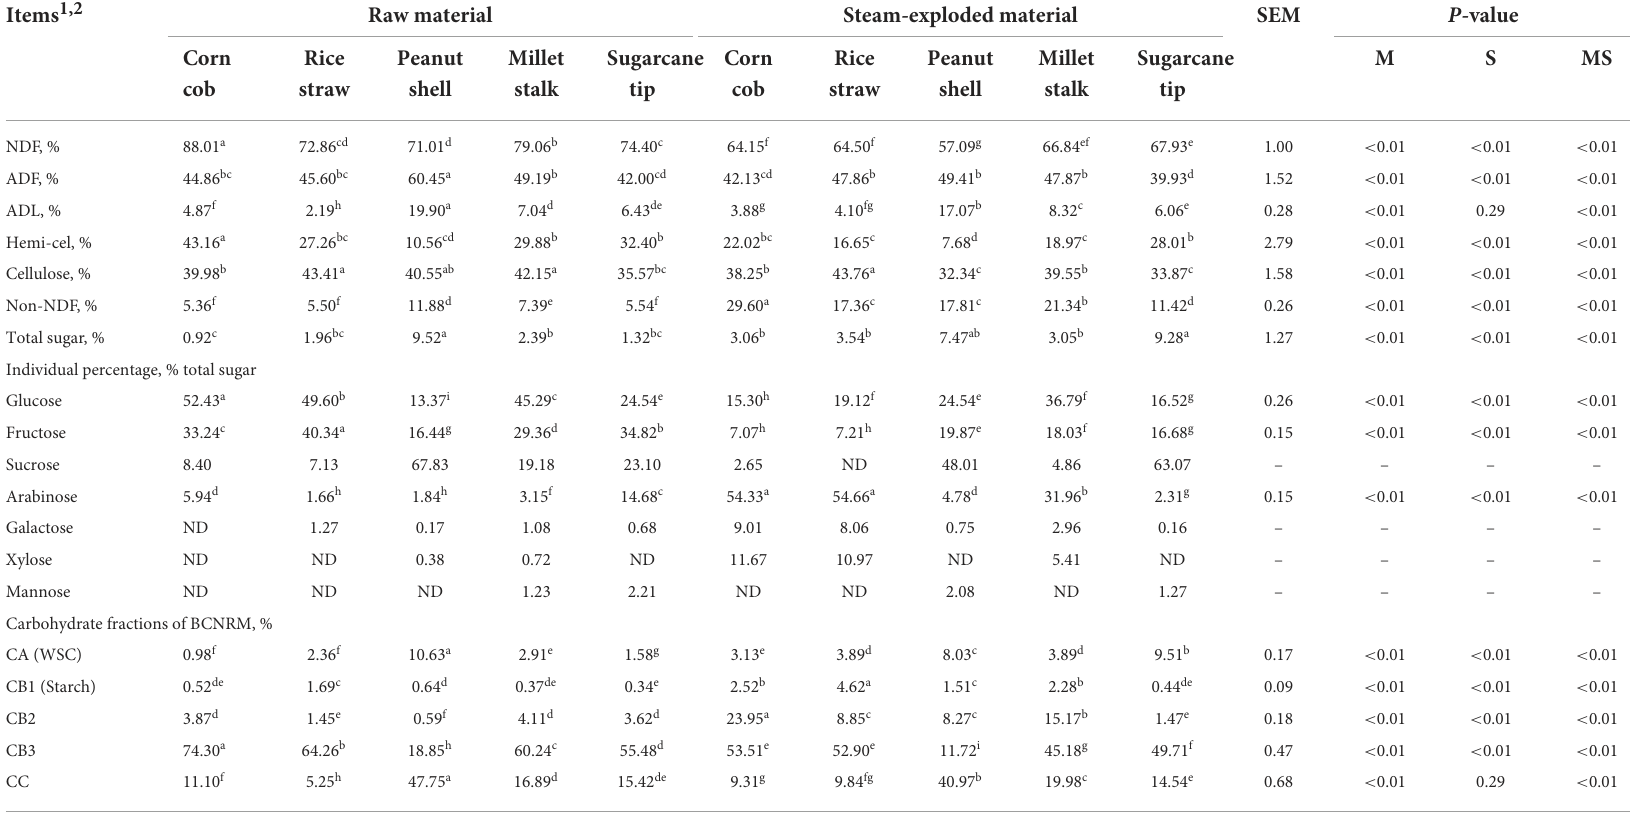
TABLE 1 Carbohydrate constituents of feedstuff before and after steam explosion processing. Items